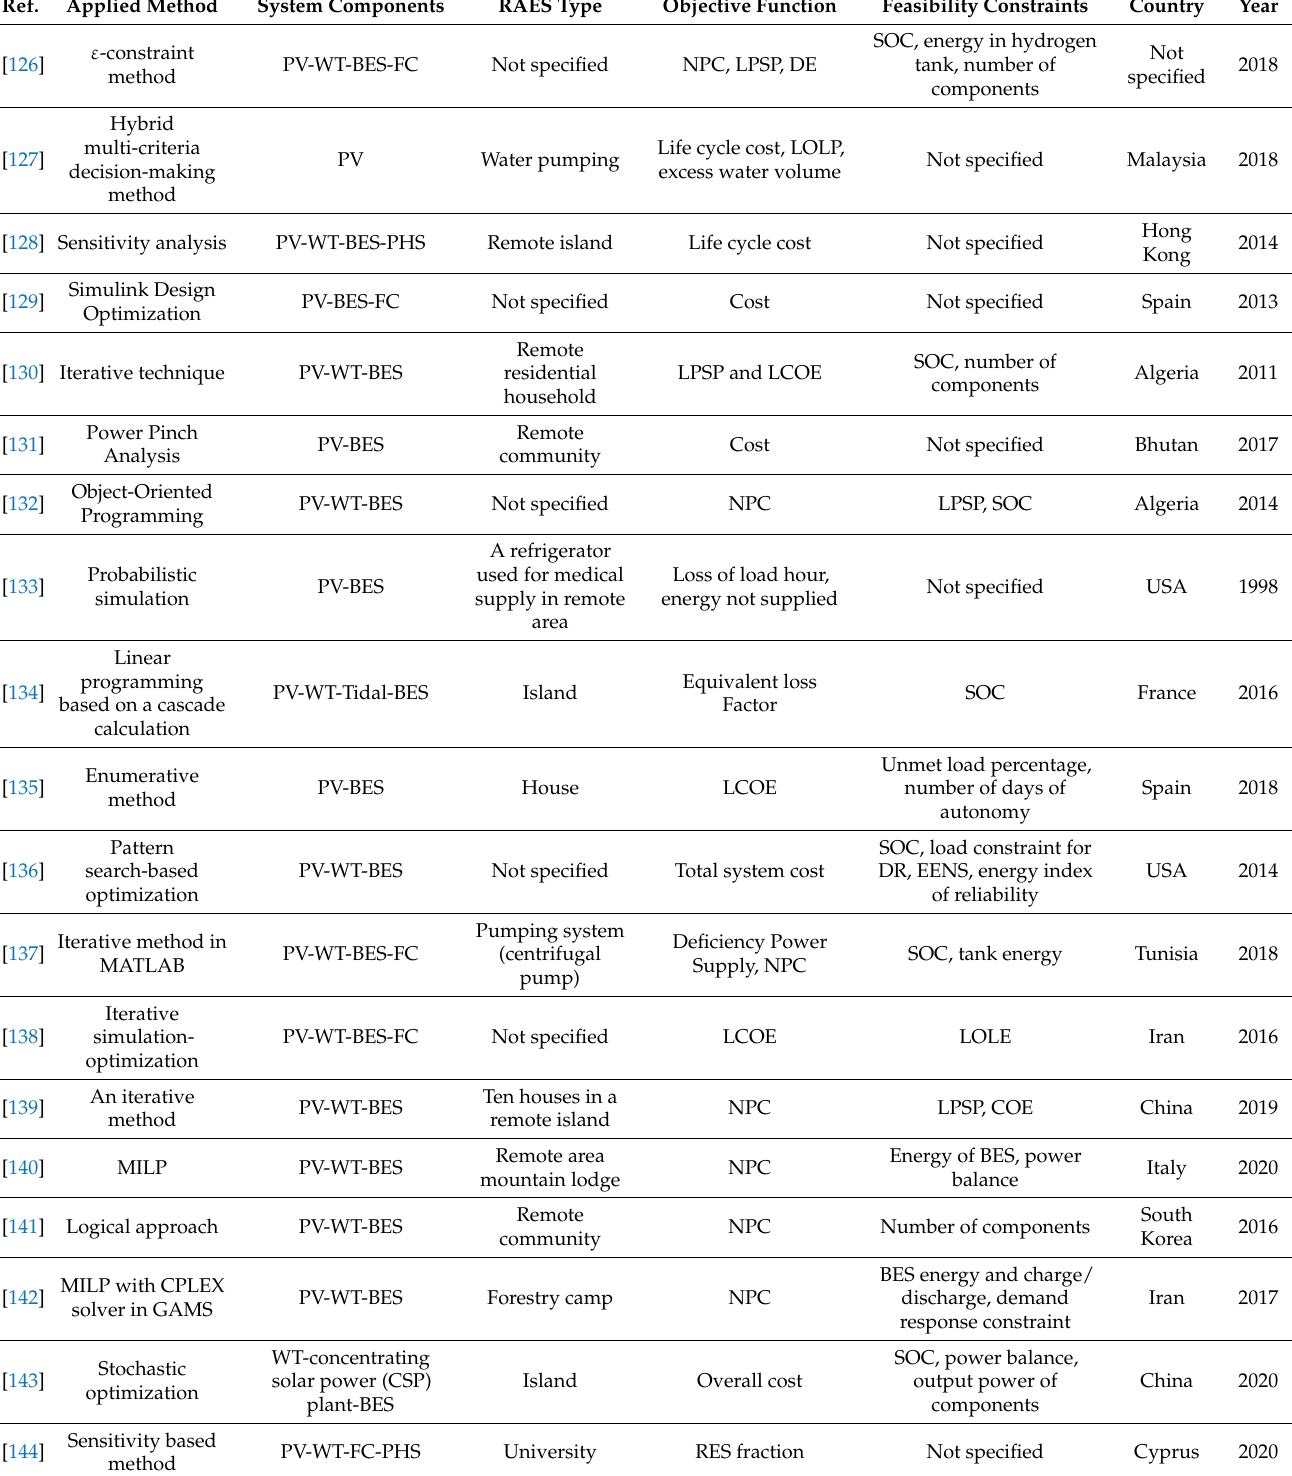
Table 9. Existing studies on optimal planning of clean RAES systems with non-metaheuristic methods.